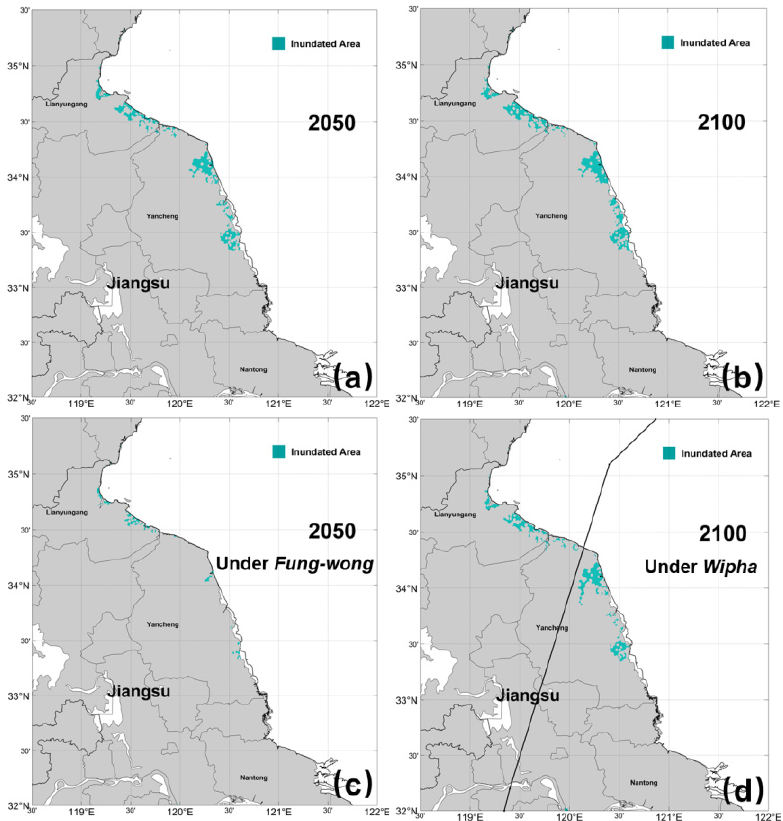
Figure 13. Possible inundation (blue color) of the YRD due to SLR in 2050 ( a ) and 2100 ( b ) without sea walls. ( c , d ) are the same as ( a , b ), but for the cases where typhoons such as Fung-wong (2014) and Wipha (2007) approaching or passing by the study area. The solid black line shows the typhoon track.